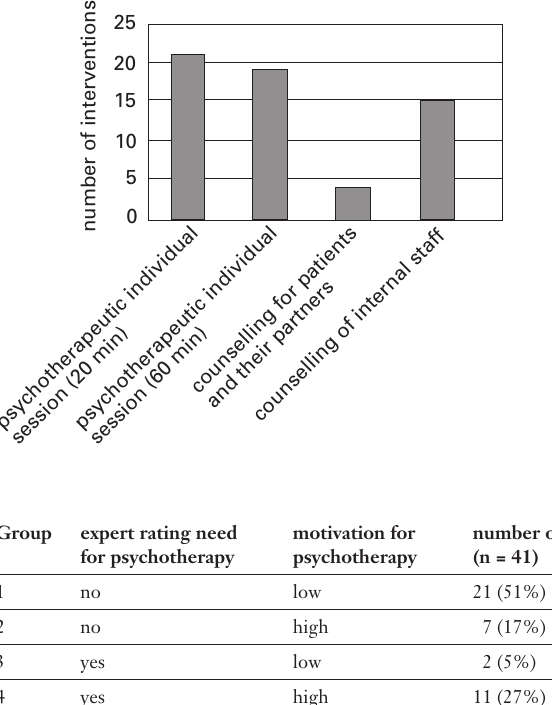
Distribution of men- tal disorders based on ICD 10 Chapter F 1–6 in the group of patients who re- ceived psychothera- peutic interventions (n =